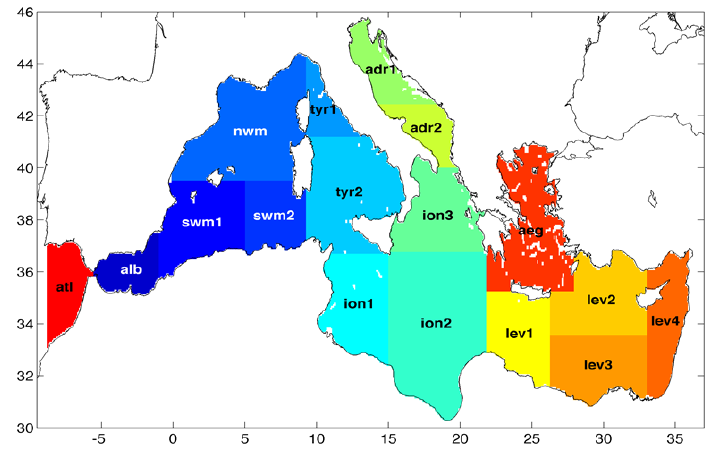
Figure 3. Mediterranean Sea subregions for qualification